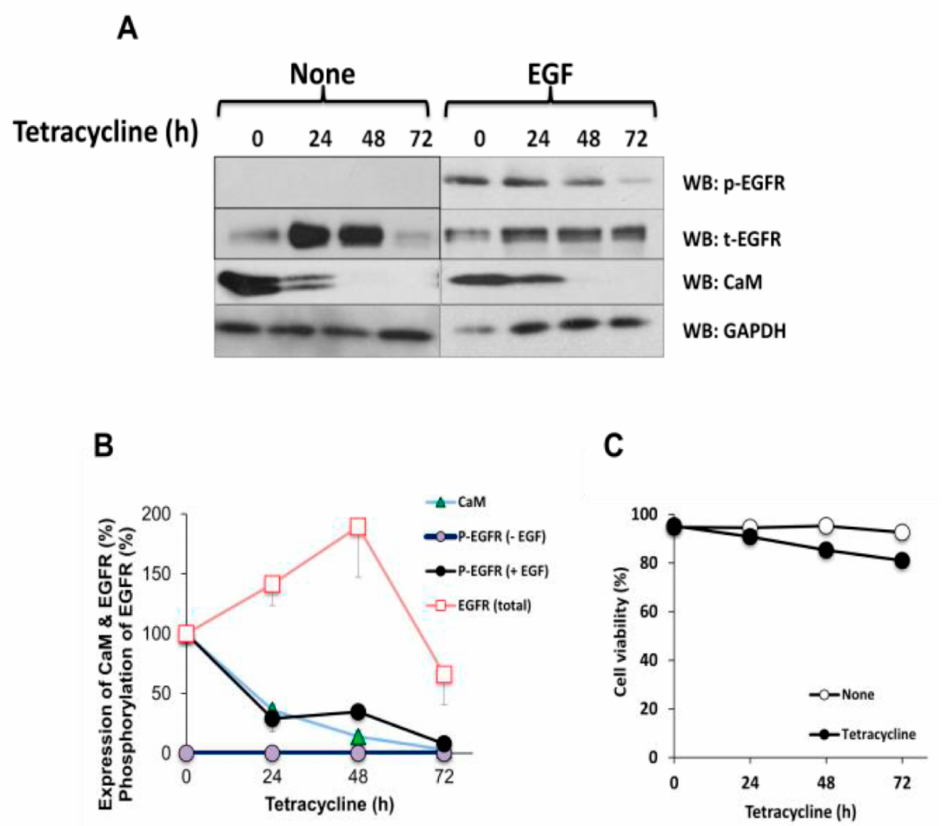
Figure 3. CaM downregulation in conditional CaM-KO cells decreases EGF-dependent EGFR acti- vation. ( A ) ET1-55/EGFR cells were incubated with 1 μ g/mL tetracycline (TET) for the indicated times and stimulated with 10 nM EGF for 5 min. The expression of EGFR ( t-EGFR ), phospho-EGFR ( p-EGFR ) and CaM were determined using a monoclonal (rabbit IgG) anti-EGFR antibody (clone E235) from Millipore recognizing the C-terminal region, a monoclonal (mouse IgG 2b κ ) anti-phospho- tyrosine antibody (clone 4G10) from Upstate Biotechnology recognizing anti-phospho-EGFR and a monoclonal (mouse IgG 1 ) anti-CaM antibody from Millipore, respectively. GADPH, determined using a monoclonal (rabbit IgG) anti-GAPDH antibody (clone 14C10) from Cell Signaling Technology, is also shown as a loading control. ( B ) The plot presents the mean ± SEM (n = 5 for total EGFR, n = 3 for phospho-EGFR, and n = 3 for CaM) expression of total EGFR (red squares), phospho-EGFR in the absence (gray circles), presence (black circles) of EGF and CaM (green triangles) in the presence of TET for the indicated times. ( C ) The plot represents the mean ± SEM (n = 3) cell viability measured by trypan blue exclusion test in the absence and presence of TET for the indicated times (Stateva and Villalobo, additional data to [44]).